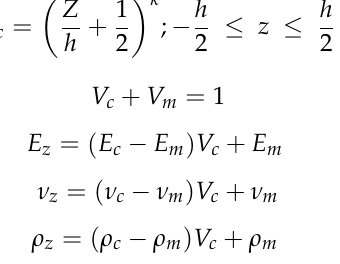
Table 1. Properties of the FGM constituents